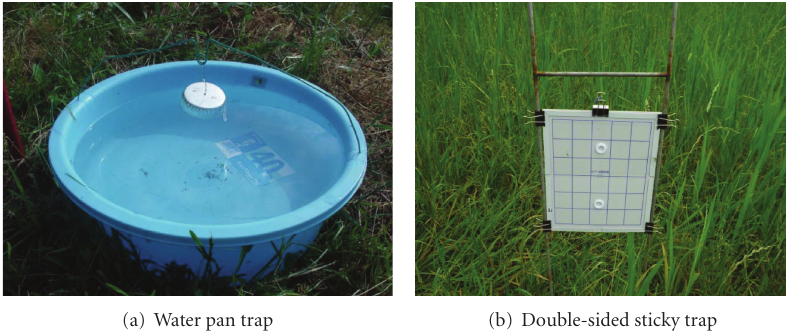
Figure 5: Typical water pan trap (a) and double-sided sticky trap (b) tested for catching mirid bugs.